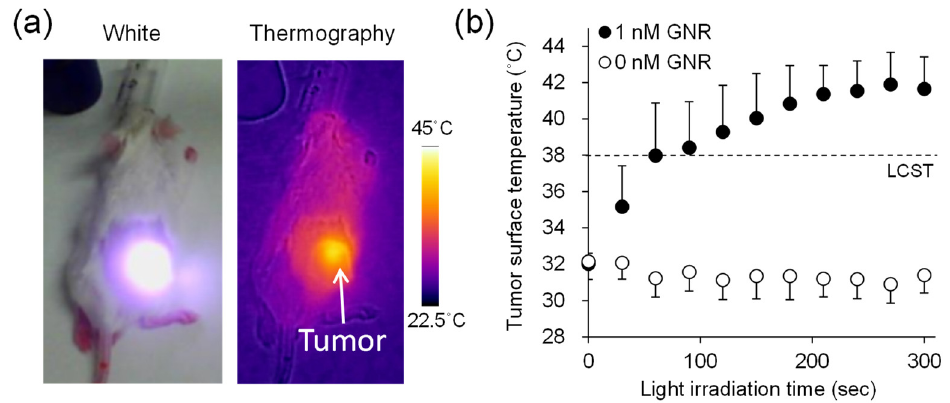
Figure 4. Change in tumor surface temperature under near-infrared (NIR) light irradiation to the tumor where gold nanorods (GNRs) were highly taken up. ( a ) Thermographic images. ( b ) Change in tumor surface temperature after irradiation. LCST: lower critical solution temperature.